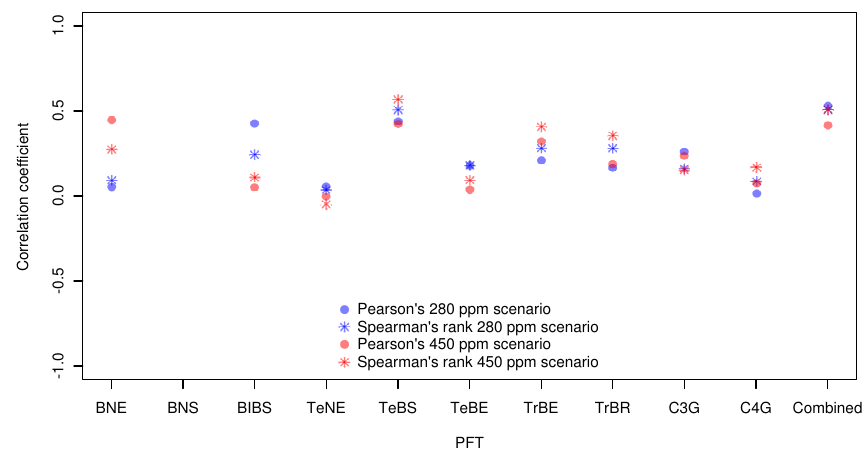
Figure D1. Pearson’s product moment correlation coefficient and Spearman’s rank correlation coefficients between the palaeobotanical data diversity fractions and the simulated LAI fractions for the 280 and 450ppm CO 2 Tortonian scenarios, for each PFT and for all PFTs